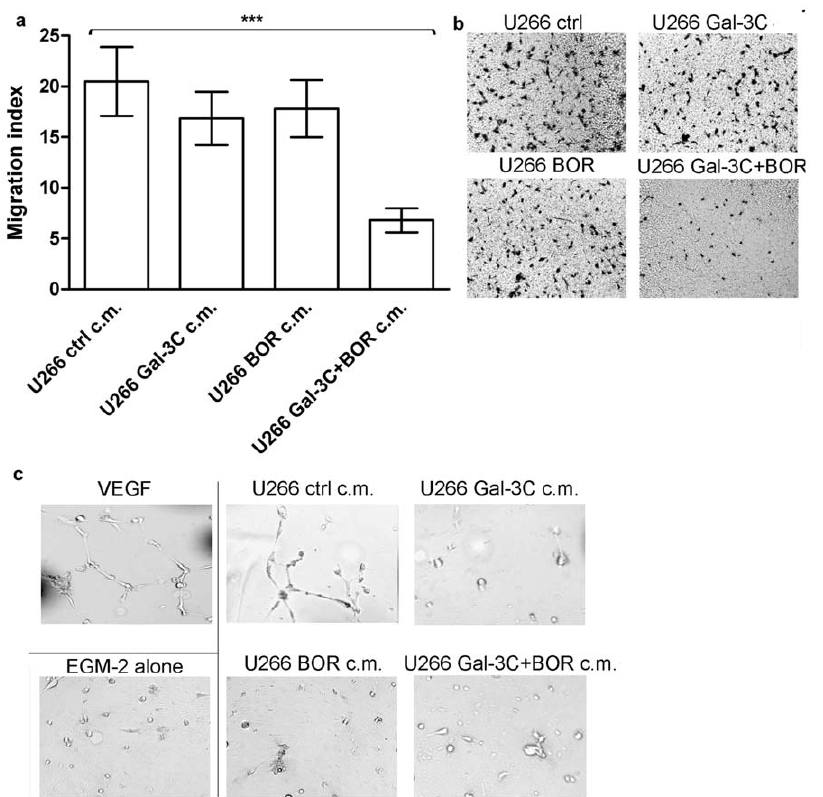
Figure 3. Vascular endothelial cell migration and tubule formation. ( a ) 5 6 10 4 serum-starved HUVEC cells were loaded in the upper chamber of a Transwell H plate (8 m m-diameter pores). The bottom chamber was filled with 600 m L serum-free EBM-2 medium supplemented with 20% V/V conditioned (c.m.) derived from U266 cultures undergone different treatments: control (ctrl), Gal-3C, Bor, or Gal-3C and Bor combined (Gal-3C + Bor). EBM-2 medium alone was used as a negative control. After 16-h incubation, chamber filters were removed and migrated cells were fixed and stained with Coomassie brilliant blue as described in Materials and Methods. Mean migration indices (error bars are 6 SD) were expressed as the number of cells migrated in the presence of the indicated stimulus divided by the number of cells migrated in the presence of EBM-2 alone. One-way ANOVA and Tukey’s post-test indicated that Gal-3C + Bor migration index was significantly different from control (* P , 0.001), while no significant difference was detected between the control and Gal-3C or Bor alone ( P . 0.05). All assays were run in triplicate. ( b ) representative pictures of the filters. ( c ) 5 6 10 3 serum-starved HUVEC were allowed to form tubules on a Matrigel TM surface for 16 h in the presence of VEGF (positive control), EMB-2 medium alone (negative control), or EBM-2 supplemented with 20% V/V U266 c.m. Representative pictures from 3 comparable experiments are